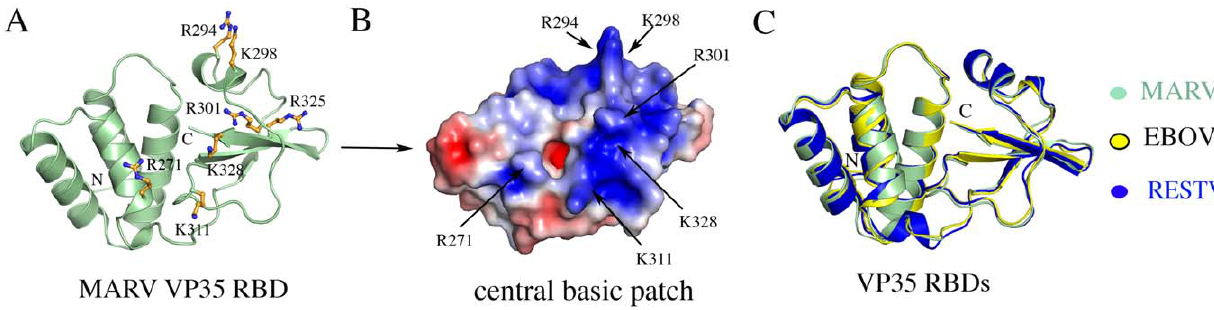
Figure 1. Structure of the MARV VP35 dsRNA binding domain (RBD). (A) Cartoon representation of the MARV VP35 RBD showing the a - helical and b -sheet subdomains. Basic residues in the central basic patch are shown in ball-and-stick representation and colored orange. (B) Electrostatic surface representation of MARV VP35 RBD with limits of 6 3 k B T/e c showing the highly conserved central basic patch. Key residues on the patch are labeled. (C) Superposition of VP35 RBD molecules from MARV (pale green), EBOV (yellow) and RESTV (dark blue) showing a conservation of the fold and secondary structure.